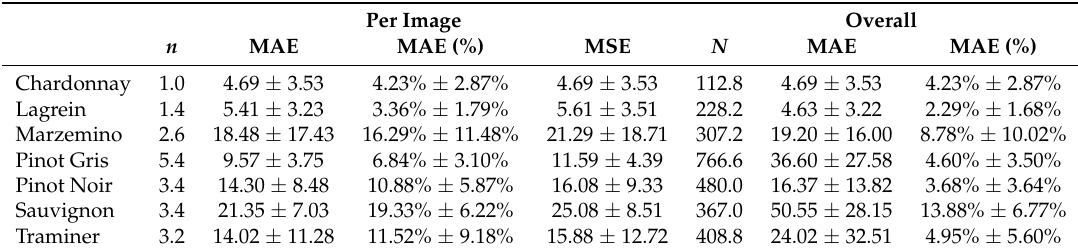
Table 5. Application of GBCNet on CR1 dataset with 5-CV. Results are reported for all the varieties used in this work, with the average number of images ( n ) and berries ( N ) per fold. Results are formally reported as mean ± sd, where sd may be larger than mean.